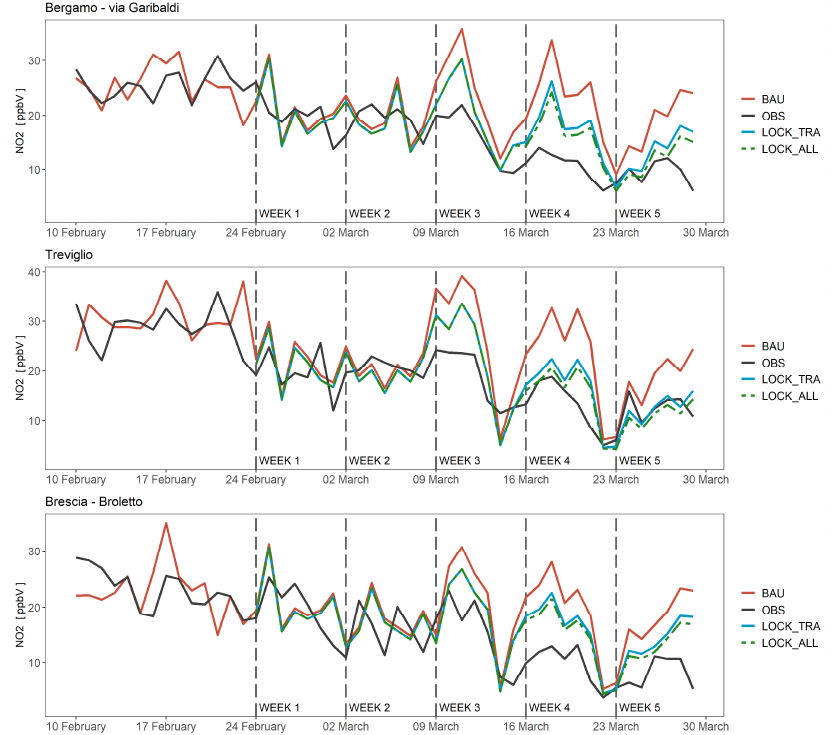
Figure 10. NO 2 time series simulated for the BAU (red), LOCK_ALL (light blue), and LOCK_TRA (green) scenarios, compared to the observations (black) in the Lombardy region selected monitoring sites.